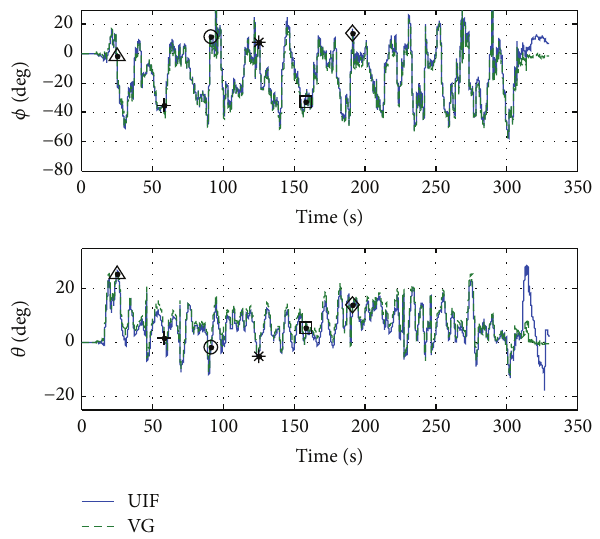
Figure 8: Roll and pitch estimation results for Flight #2.